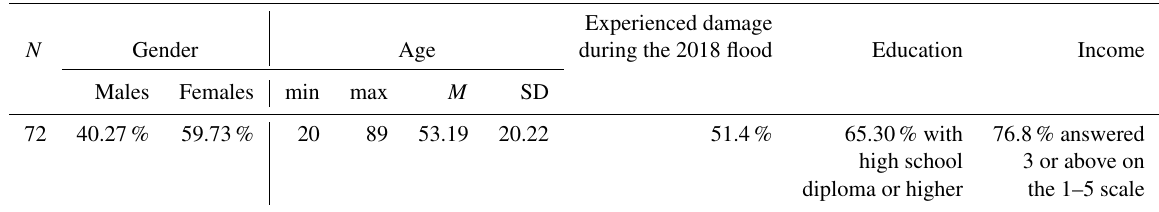
Table 3. Summary statistics for the respondents who dropped out between round 1 and round 2.